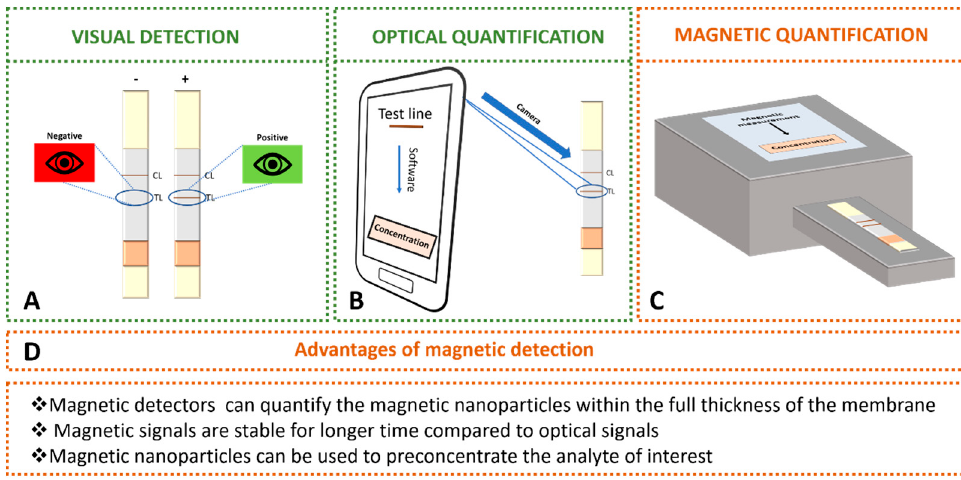
Figure 5. Detection of magnetic nanoparticles used as labels in LFIA: ( A ) visual detection by naked eye. ( B ) Optical detection using smartphone with special software. ( C ) Magnetic quantification using magnetic transduction. ( D ) Advantages of magnetic detection over optical detection.